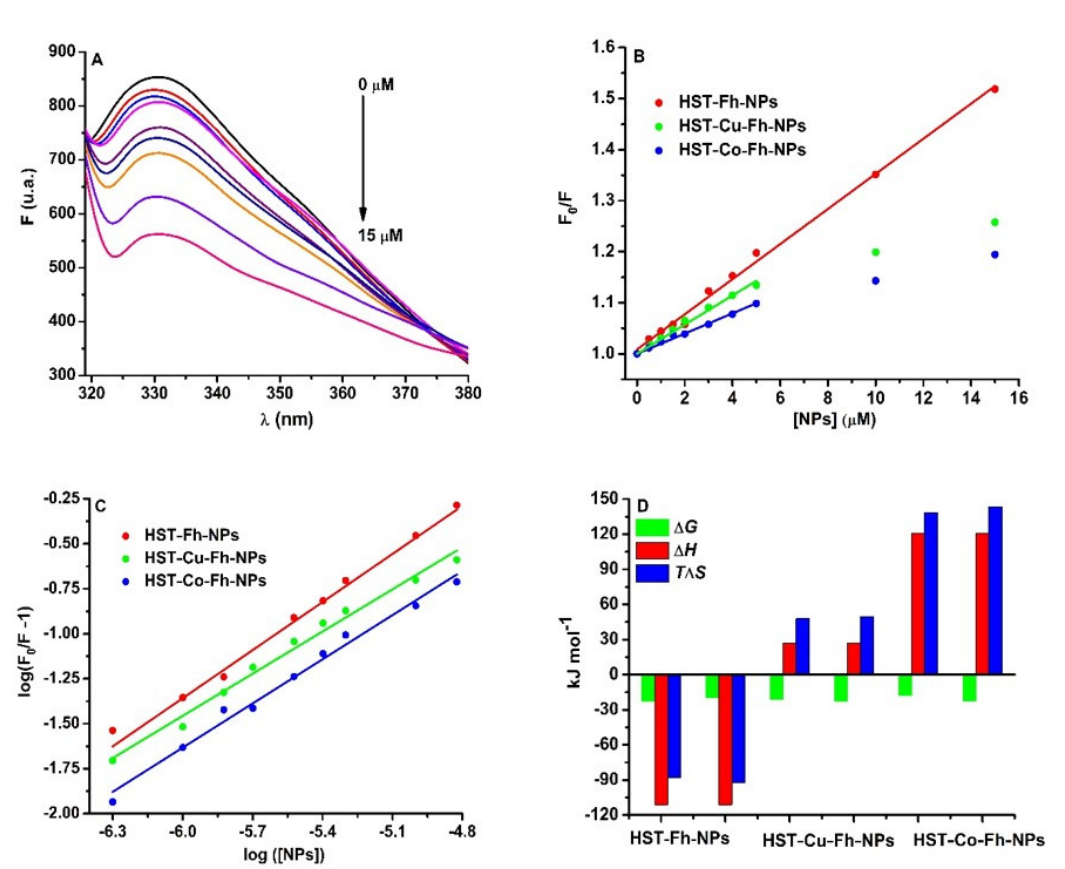
Figure 1. ( A ): The fluorescence emission spectra of HST (3 µ M) in the presence of Fh-NPs (0–15 µ M), ( B ) the Stern-Volmer representation of F 0 /F vs. [NPs] for HST in complex with Fh-NPs ( • red), Cu-Fh-NPs ( • green), and Co-Fh-NPs ( • blue) (0–15 µ M), and ( C ): the Scatchard plot of log (F 0 /F − 1 ) against log[NPs]. All samples were prepared in 100 mM HEPES buffer, at pH 7.35 and were recorded at 25 ◦ C. ( D ) The thermodynamic parameters for the binding of the Fh-NPs, Cu-Fh-NPs, and Co-Fh-NPs with